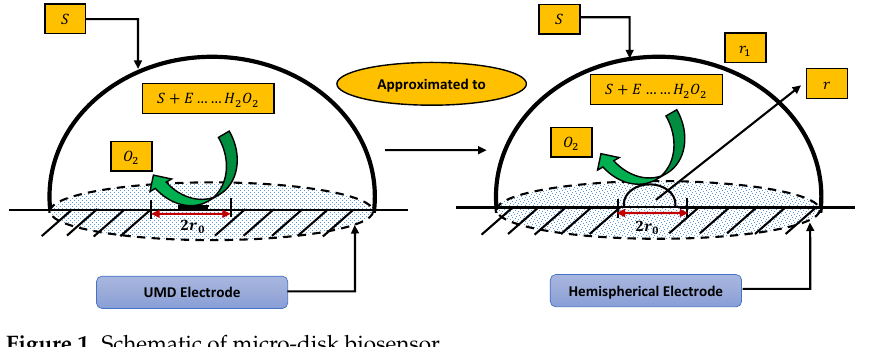
Figure 1. Schematic of micro-disk